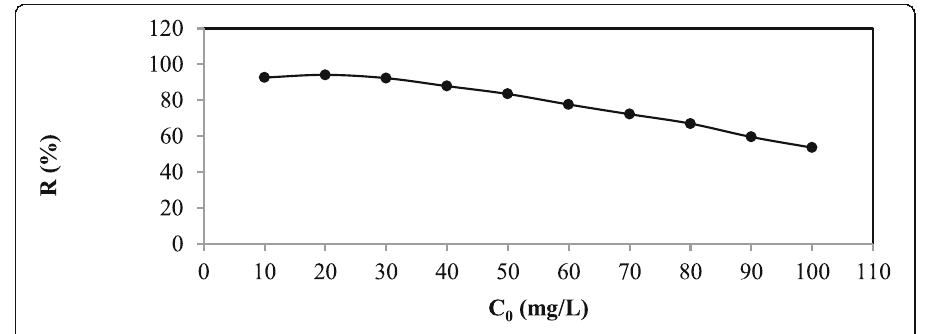
Fig. 10 Nickel removal efficiency as a function of initial concentration